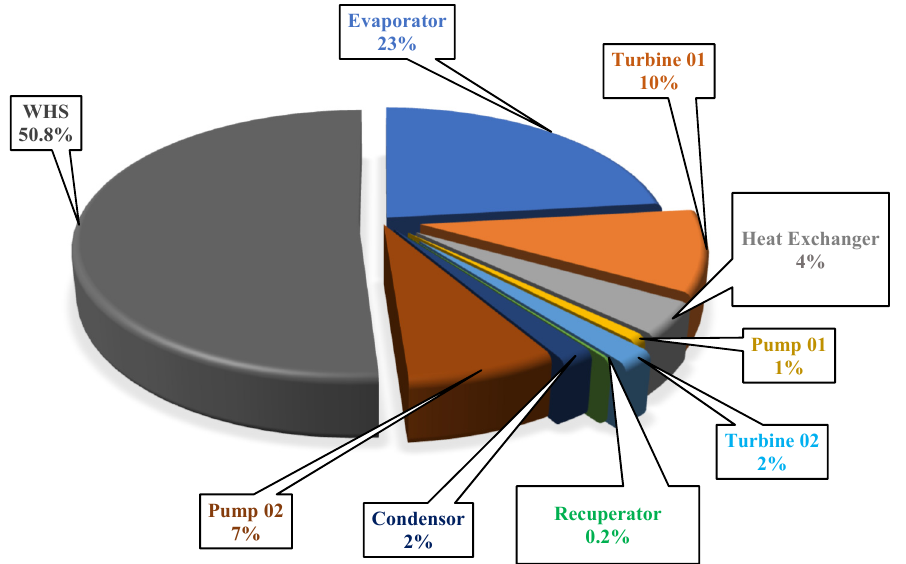
Figure 14. Percentage of individual components exergy destruction at 350 °C heat source temperature in January.